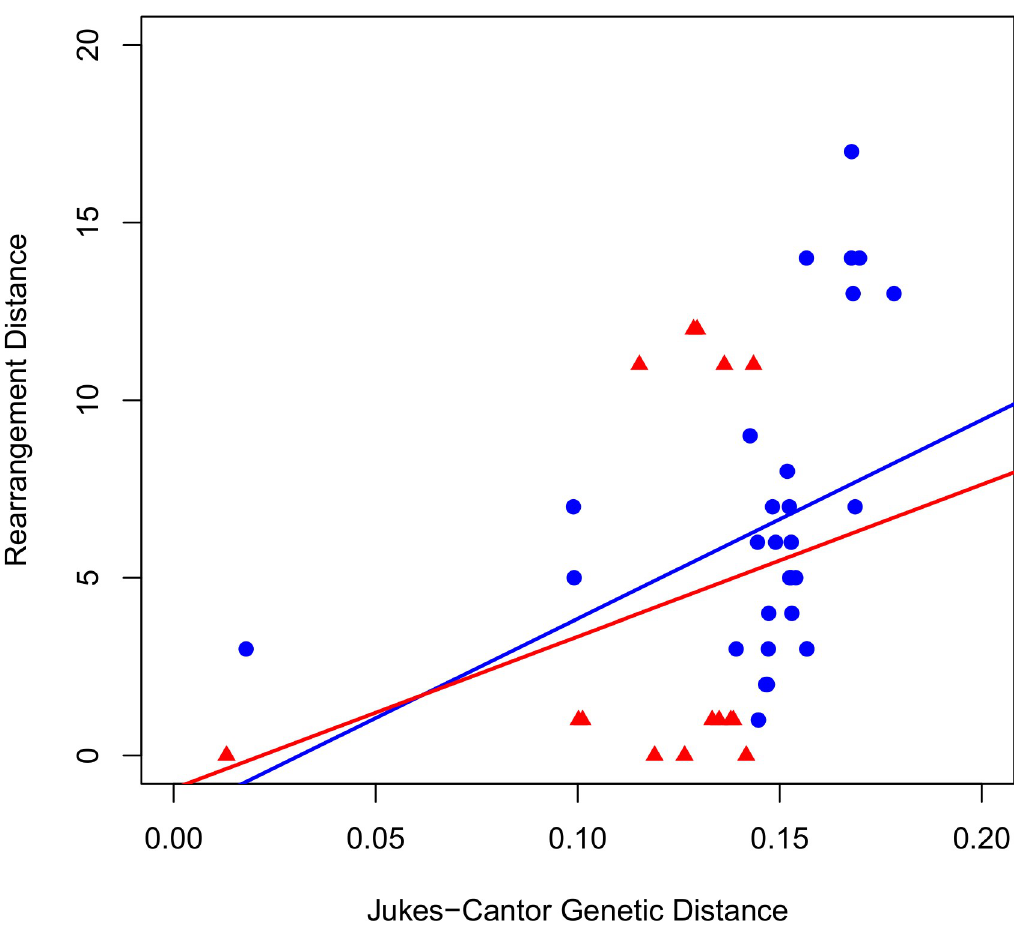
Fig 5. Plot describing the relationship between rearrangement distance and Jukes-Cantor genetic distance. Blue circles represent biraphid diatoms. Red triangles represent thalassiosiroid diatoms. Regression coefficient for the biraphid diatoms is significant (p = 0.04, R 2 = 0.136), whereas for the thalassiosiroid diatoms it is not (p = 0.34, R 2 =